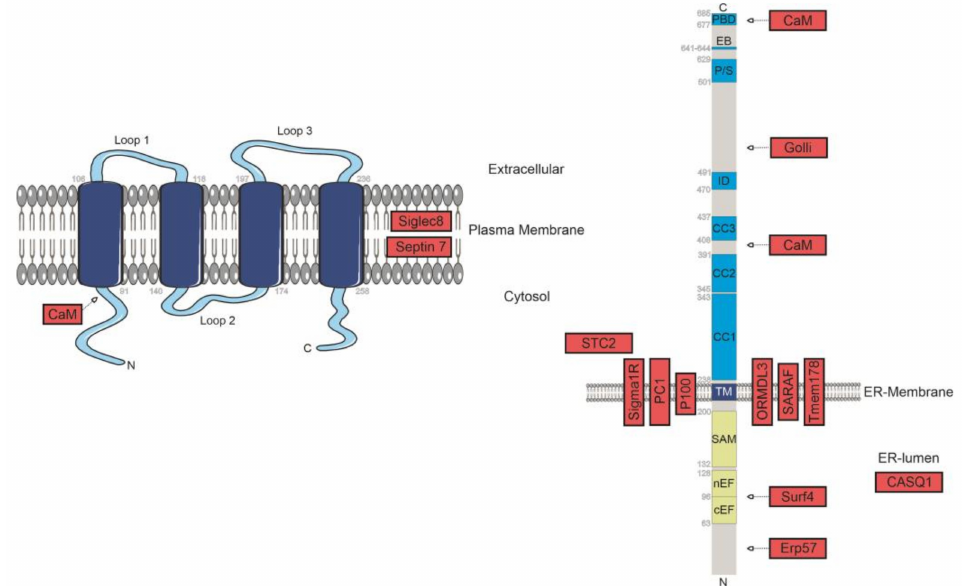
Figure 2. Identified negative regulators of store-operated Ca 2+ entry (SOCE). Known protein-localisation together with potential identified interaction sites between STIM1/Orai1 and regulatory-interacting proteins are represented in red